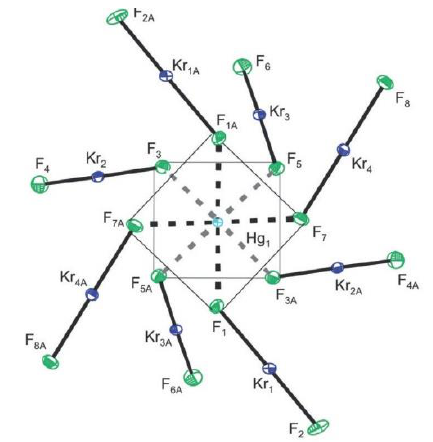
Figure 19. The [Hg(KrF 2 ) 8 ] 2 + cation in the single-crystal X-ray structure of [Hg(KrF 2 ) 8 ][AsF 6 ] 2 · 2HF